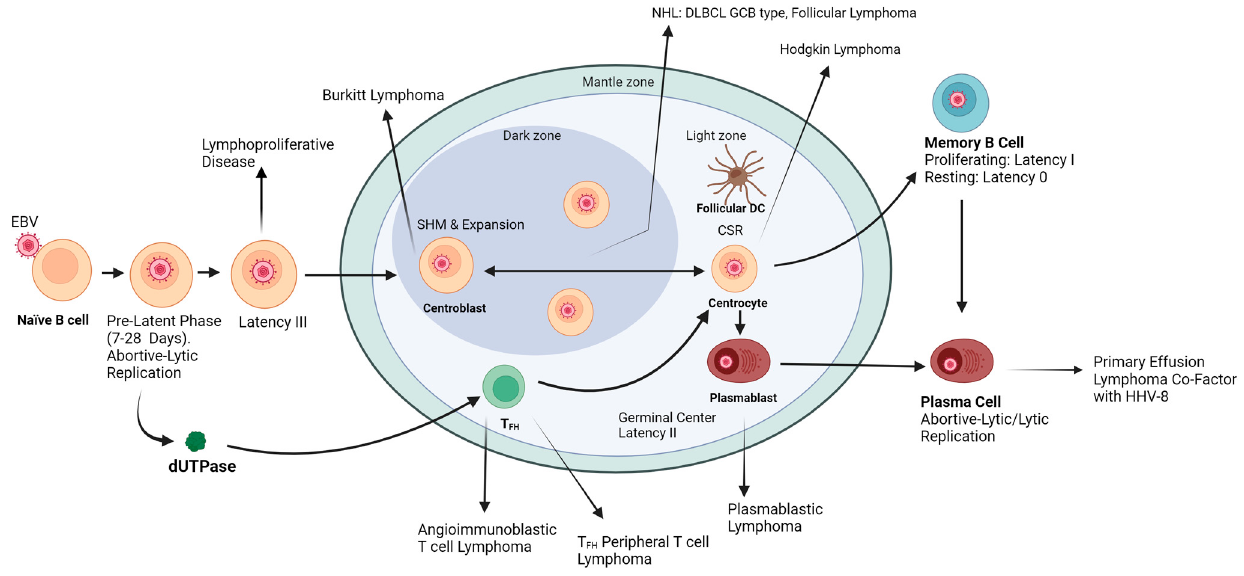
Figure 1. Illustration of germinal center (GC) reaction indicating the events required for affinity maturation of antibody responses, the potential role of the EBV dUTPase protein in this process, and the cellular origins of various EBV-associated B- and T-cell lymphomas. DC = dendritic cell; SHN = somatic hypermutation; CSR = class-switch recombination; T FH = follicular CD4 + helper T cell.